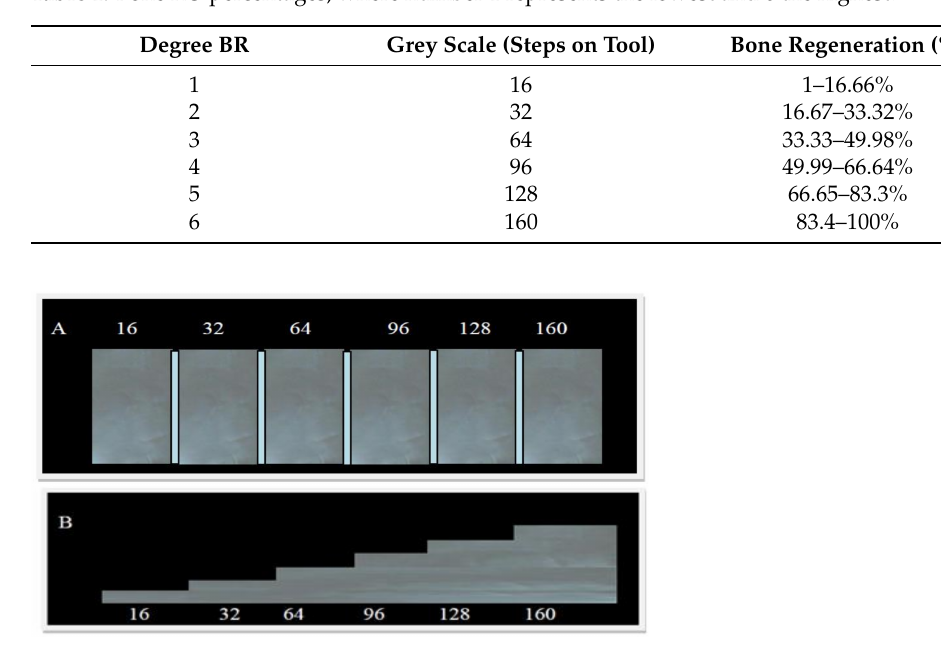
Figure 2. Grey Standardized Aluminum Scale ( A ) frontal view ( B ) lateral view. For the systematic evaluation of the periapical X-rays, a diagram of the alveoli was designed and divided into four quadrants: I to IV. I and IV represented the distal quadrants and II and III the mesial. Each quadrant was divided into three areas (A, B and C) from the periphery towards the center of the alveolus (Figure